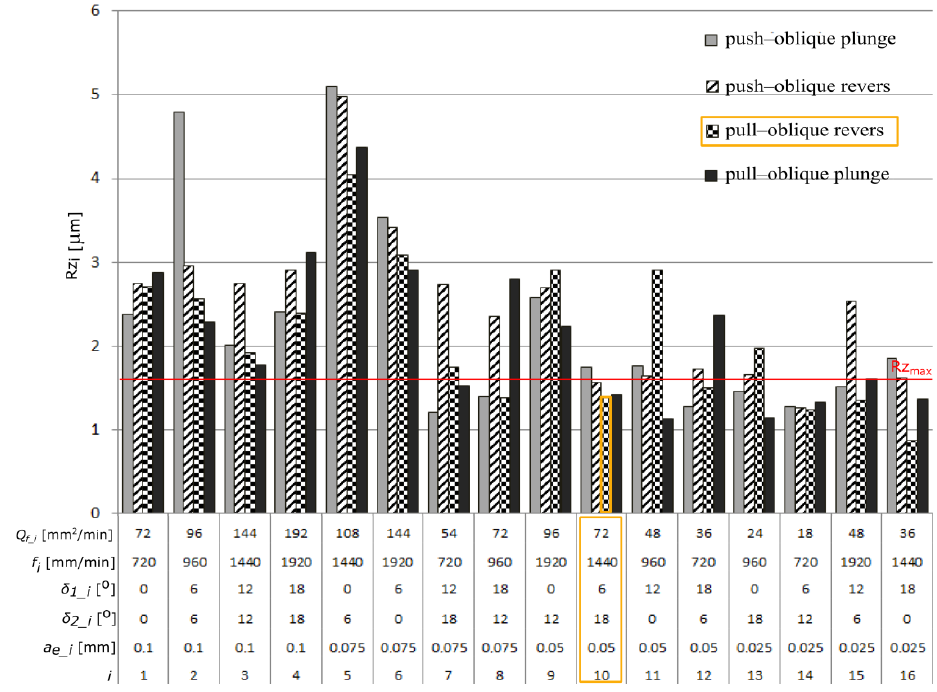
Figure 9. The average values of the surface roughness parameter Rz measured during the tests.